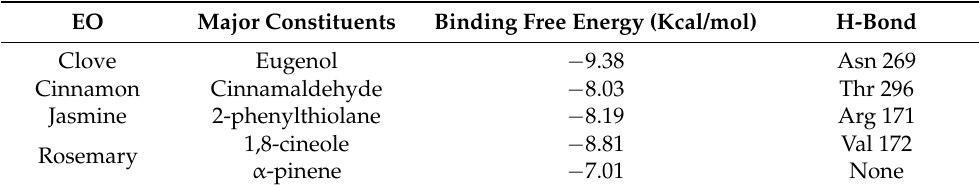
Table 4. Docking results for the major constituents of EOs into Als3 protein (PDB: 4LEE), indicating the putative binding free energy and potential hydrogen bonding residues.